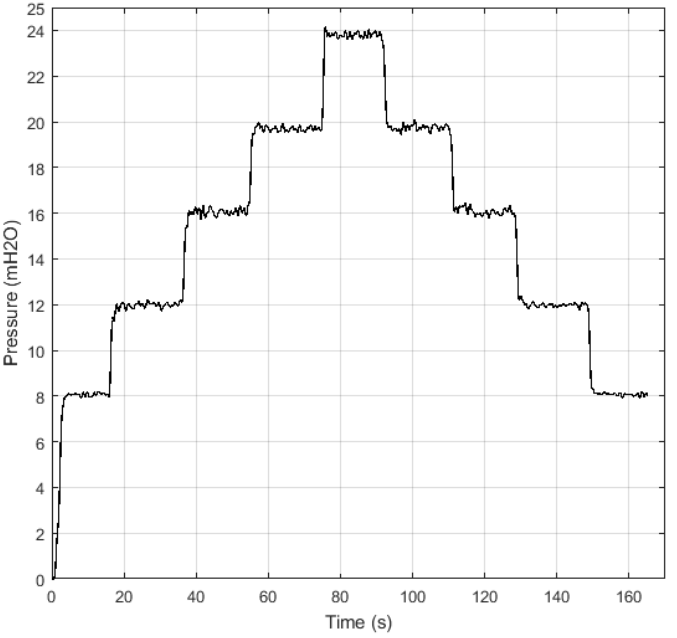
Figure 14. Control of the secondary quantity (Pressure) in the test phase for different set-point values: 8, 12, 16, 20, and 24